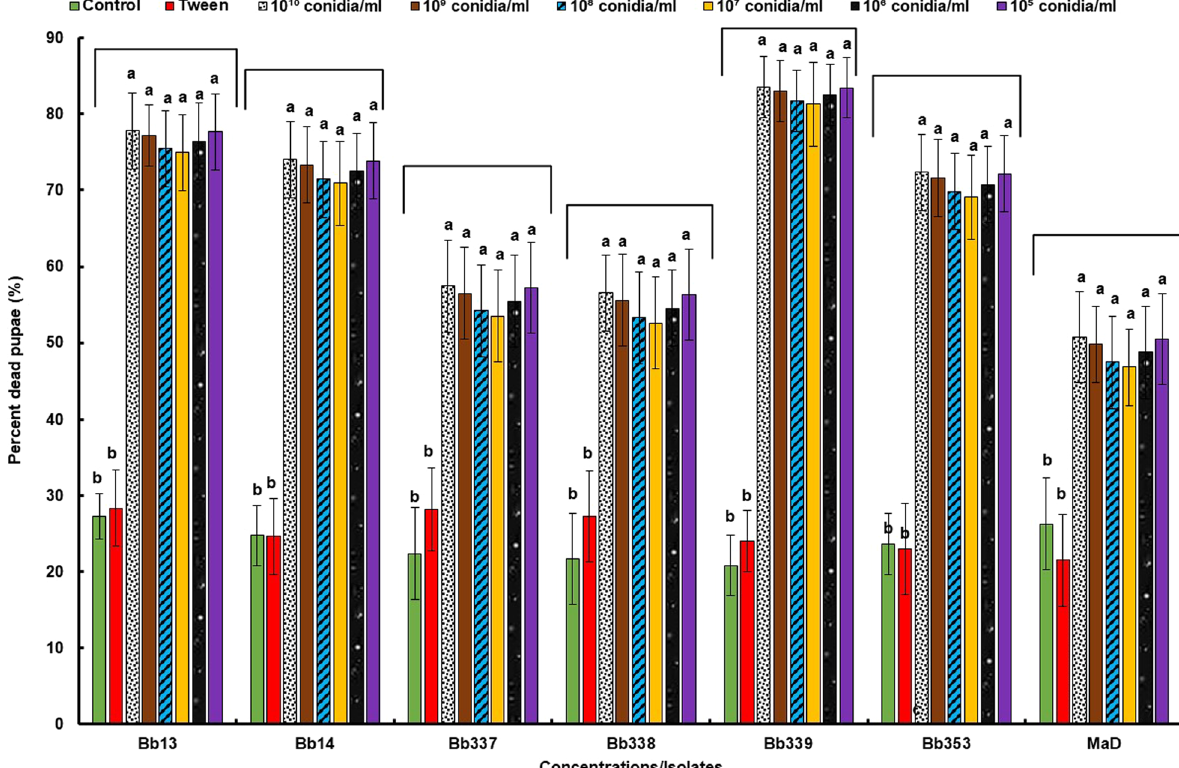
Fig. 3 Mortality of Zeugodacus cucurbitae pupae after treatment with different concentrations of isolates of Beauveria bassiana and Metarhizium anisopliae in pupal inoculation